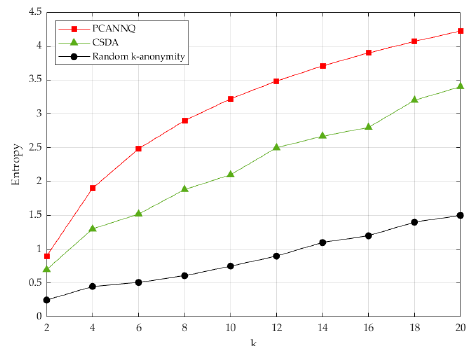
Figure 11. Security of locations.